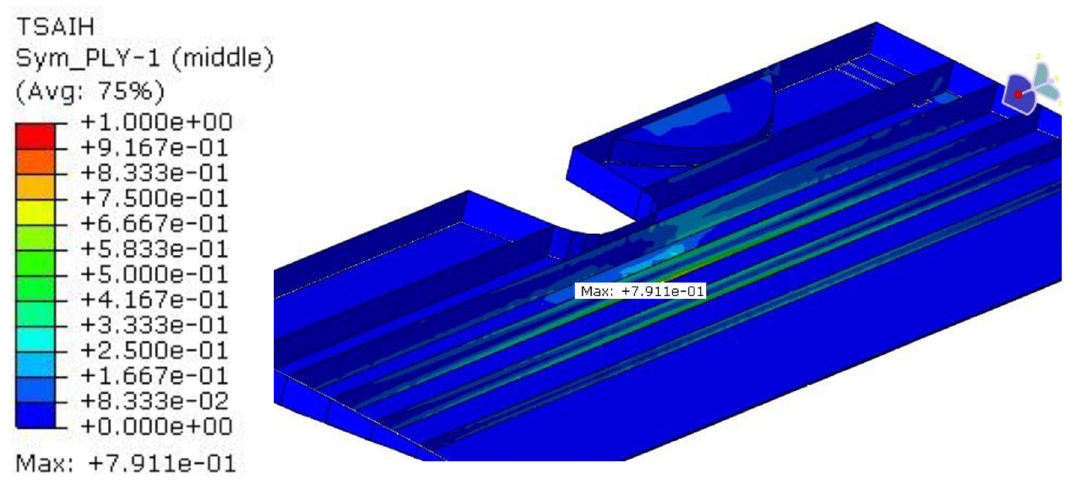
Figure 11. Tsai–Hill of improved (first optimization) 5-co-cured-spar coreless spoiler (upper skin